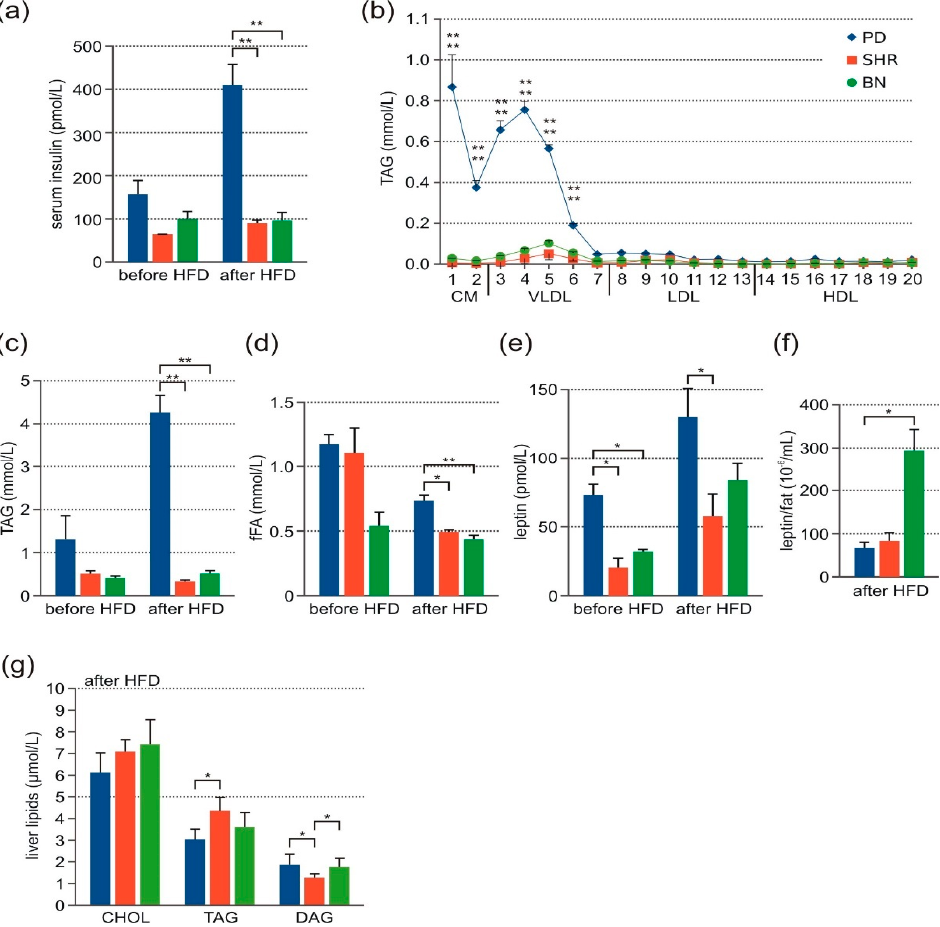
Figure 2. Laboratory findings in adult male rats-PD (blue, n = 3–7), SHR (red, n = 3–6), and BN (green, n = 3–8). ( a ) Insulin levels before and after HFD. ( b ) TAG levels after HFD in 20 lipoprotein fractions. ( c ) Total TAG levels before and after HFD. ( d ) Free FAs before and after HFD. ( e ) Absolute leptin blood level before and after HFD. ( f ) Relative leptin blood level (after correction to fat tissue amount) after HFD. ( g ) Cholesterol, TAG, and DAG levels in liver tissue. Data are presented as arithmetic means ± SEM. Statistical significance levels for the factor strain of repeated measurements ANOVA (cholesterol and TAG in 20 lipoprotein fractions) or one-way ANOVA (insulin levels, total TAG, fFAs, leptin, cholesterol, TAG, and DAG in liver tissue) are indicated for pair-wise post hoc Tukey’s test as follows: * p < 0.05, ** p < 0.01. For post-hoc TAG levels, the upper symbol corresponds to PD vs. SHR comparison, the bottom symbol represents PD vs. BN comparison.